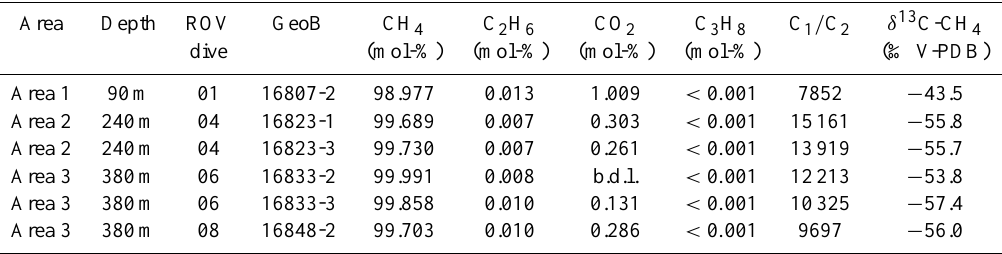
Table 2. Proportions of low-molecular-weight alkanes and CO 2 (in mol.% of 6 (C 1 –C 3 , CO 2 )) in vent gas samples taken with the gas bubble sampler (b.d.l.: below detection